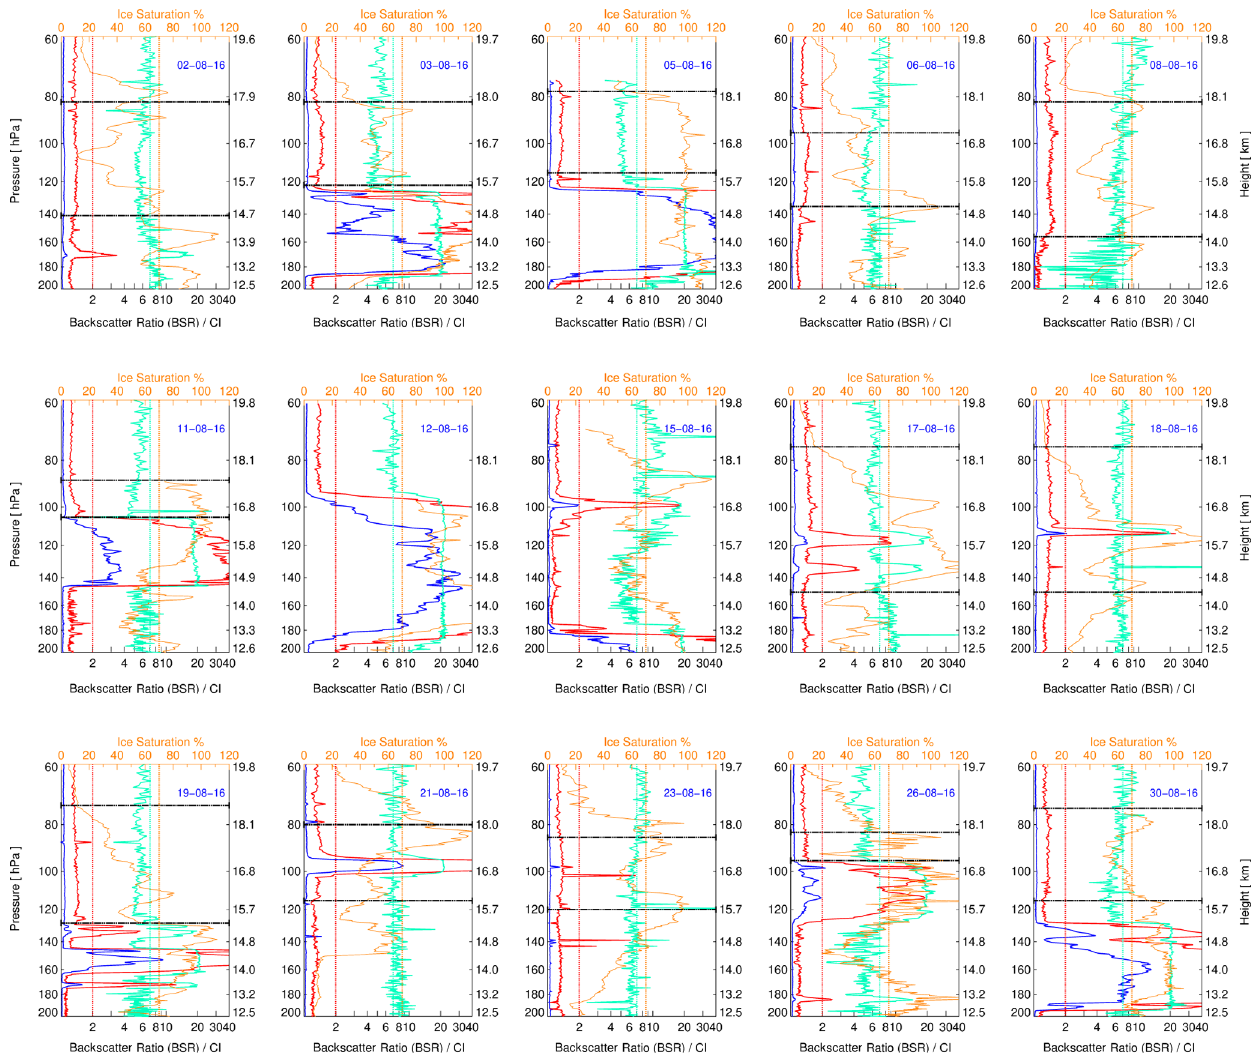
Figure A1. COBALD BSR 455 (blue) and BSR 940 (red) soundings in the UTLS region versus pressure (60–200hPa) for each flight in August 2016. In addition, the colour index (CI = ( BSR 940 − 1 )/( BSR 455 − 1 ) ; green) and the ice saturation ( S ice , orange) are shown. Corresponding height calculated using both measured pressure and temperature is also given for orientation (see right-hand y axis). In our analysis, layers with CI > 7 . 0 (CI = 7; dotted green line), BSR 940 ≥ 2 (BSR 940 = 2; dotted red line) and S ice > 70% ( S ice = 0 . 7; dotted orange line) were rejected as cirrus clouds. The top and bottom boundaries of the ATAL (see Table 1) are marked by horizontal dashed black lines, except for 12 and 15 August, as no ATAL was detected on these days (as in